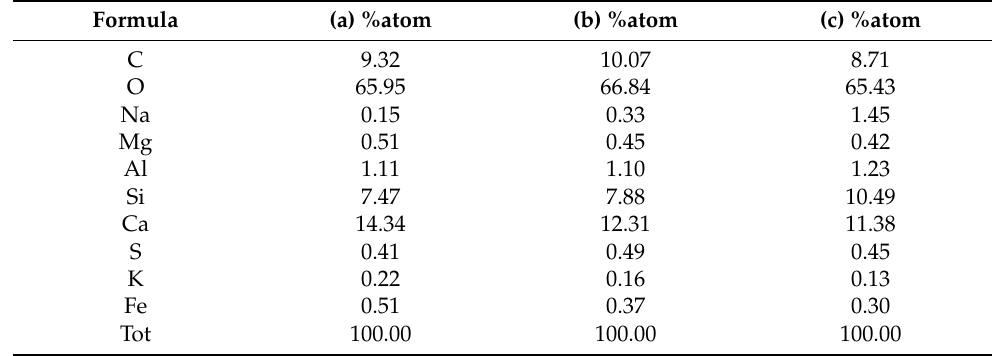
Table 2. Chemical composition of ( a ) Control mortar; ( b ) Mortar glass powder (10 %); ( c ) Mortar glass powder (50%) obtained from the EDX analysis.